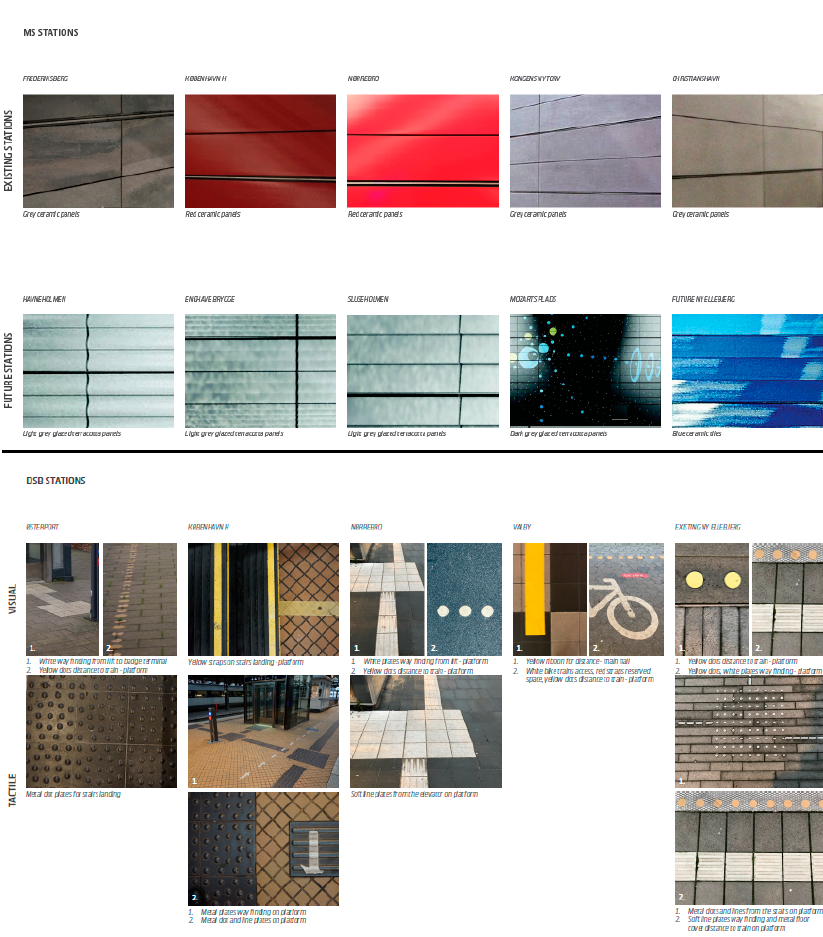
Figure 7. Material studies of existing visual and tactile guidelines at other Danish stations and metro